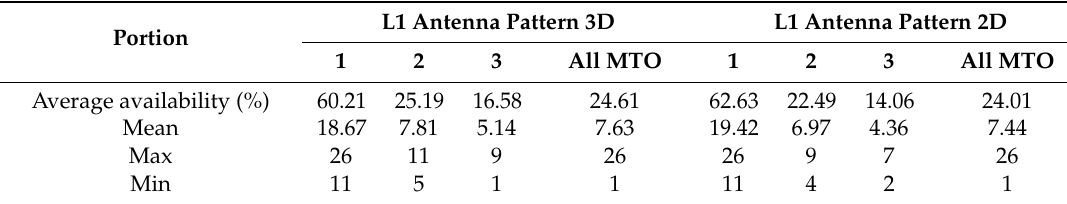
Figure 12. Geometric dilution of precision (GDOP) in log scale during the assumed MTO.